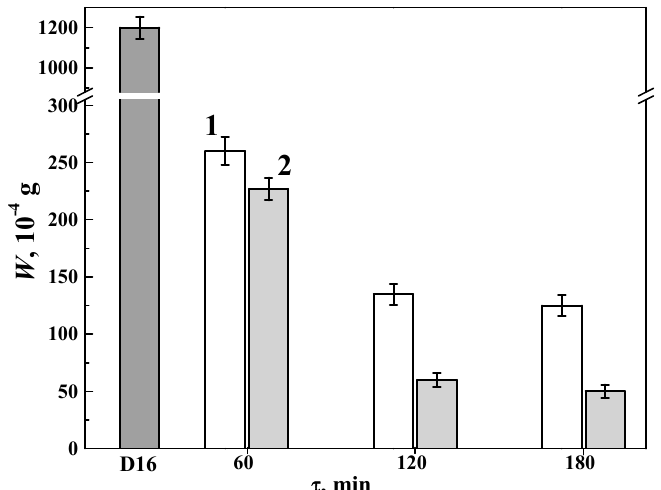
Figure 13. Effect of the duration τ of the synthesis of hard anodized layers on aluminum alloy 1011 on the mass loss W of specimens not subjected to heat treatment after synthesis ( 1 ) and after additional heat treatment at 300 °C for 1 h ( 2 ). Data for aluminum alloy D16 (2024 ISO) are given as a benchmark for comparing anodized layers on alloy 1011 in terms of their abrasive wear resistance